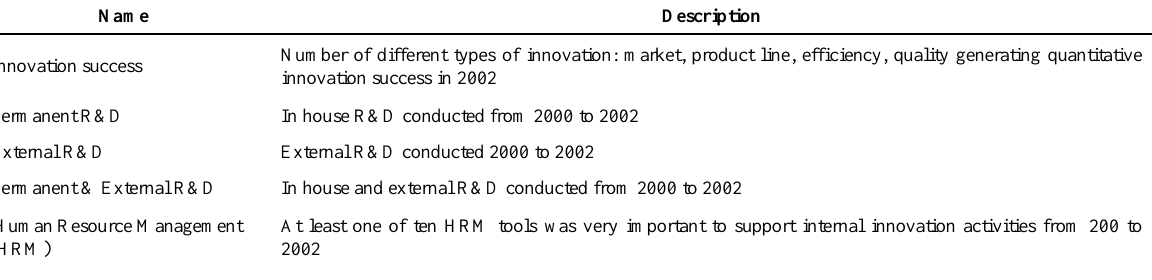
Table 2. Description of the Nine Variables Relating to R&D